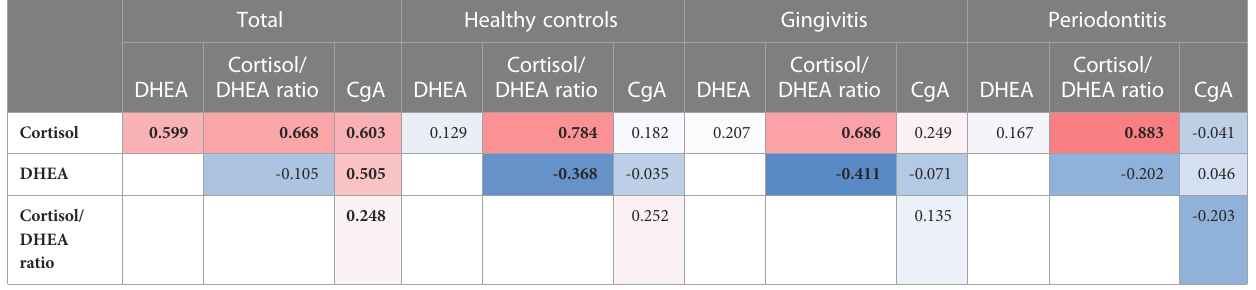
TABLE 4 Correlations among the hormonal parameters of salivary stress by